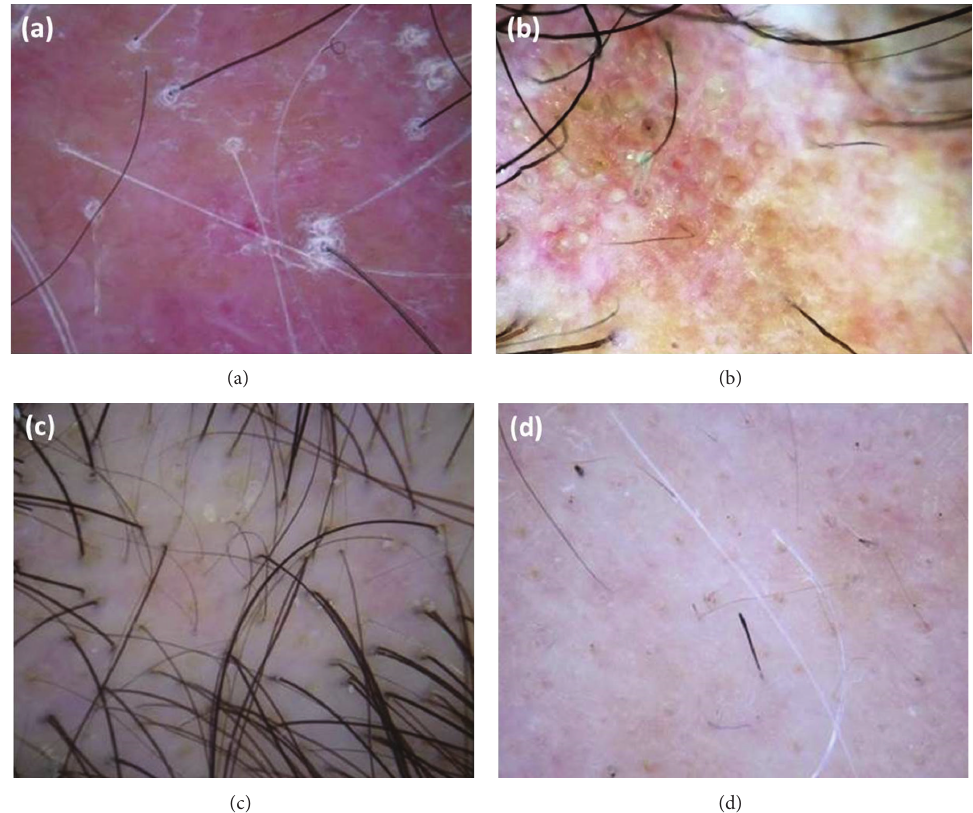
Figure 1: Clinically frequent hair disorders. Examples of scarring and nonscarring alopecia: (a) lichen planopilaris; (b) active scalp discoid lupus erythematosus with red follicular dots interspersed with scar areas; (c) androgenetic alopecia; (d) active alopecia areata. (a), (c), and (d) were captured with DermLite II PRO (3 Gen, San Juan Capistrano, CA, USA); (b) was captured with FotoFinder systems (Handyscope, Bad Birnbach, Germany) attached to the iPhone 4S (Apple, Cupertino, CA,